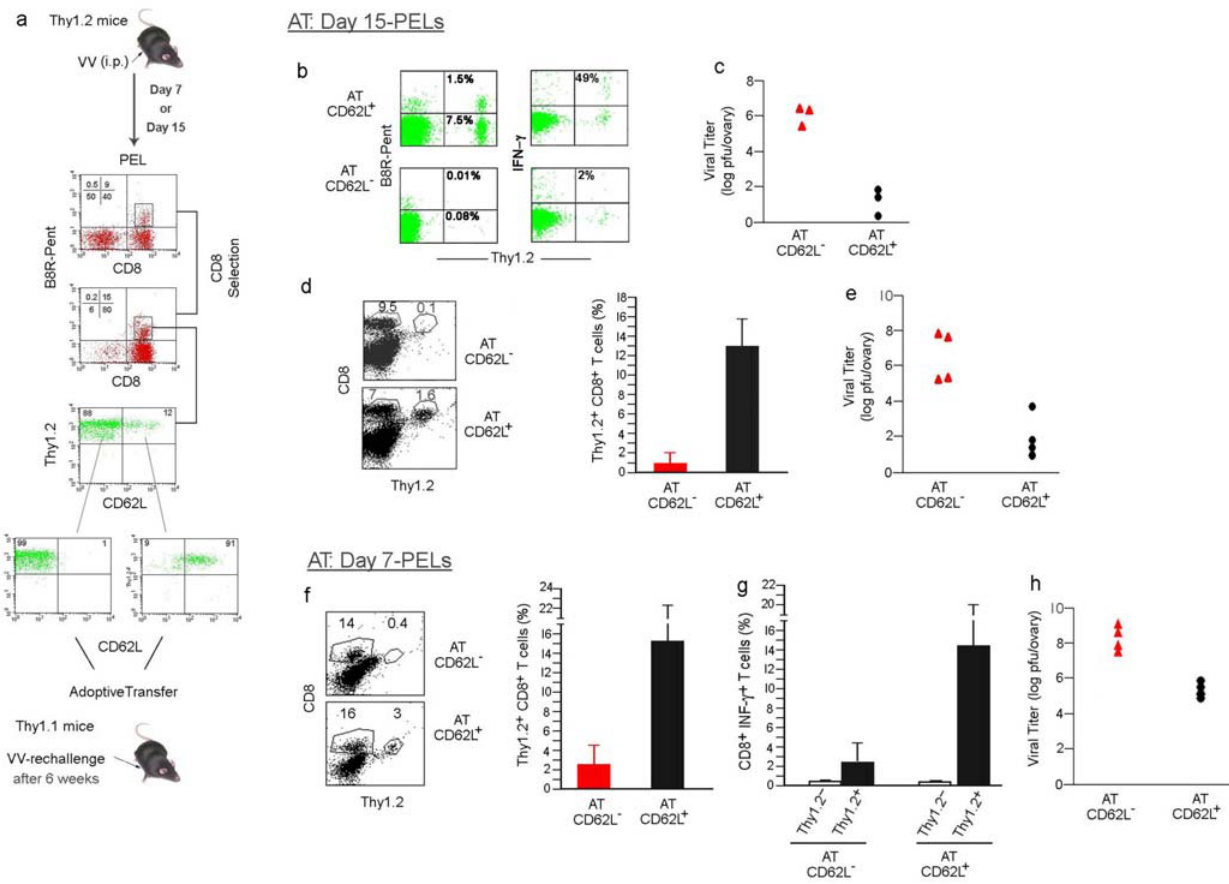
Figure 4. CD62L + CD8 T cells isolated from vv-infected mice survive for long periods of time and mount a rapid recall response. (a) Experimental approach for adoptive transfer experiments. PELs were harvested from day 7 or 15 vv-infected C57 (H-2D b , Thy1.2 + ) mice, CD8 + T cells were negatively selected and the presence of CD62L + and CD62L 2 B8R + 20–27 CD8 + cells confirmed. The CD62L 2 and CD62L + CD8 + T-cell subsets were further isolated (purity of isolated cells is shown in the bottom dot plots) and injected into naı¨ve sex-matched congenic recipient C57 (H-2D b , Thy1.1 + ) mice and the mice rested for different times before challenging with vv. (b) After 8 days of the transfer, the recipient mice were infected with vv and 3 days later, their PELs were tested for the presence of donor-derived Thy1.2 + B8R + 20–27 CD8 + T cells (left panel) or tested for